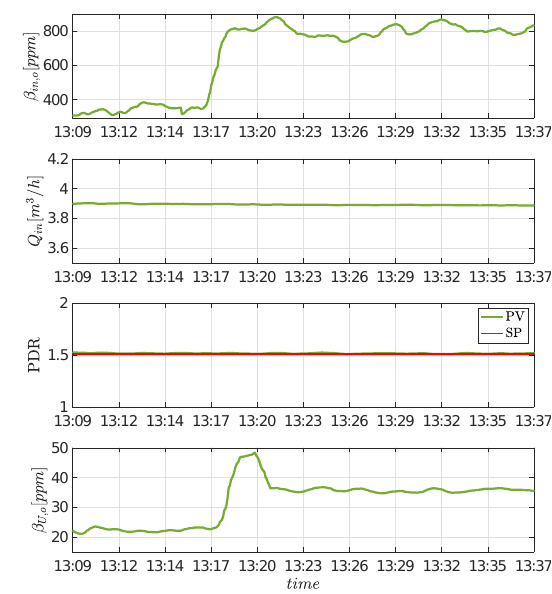
Figure 5: Laboratory experiment showing increase in the β U,o with increase in β in when fixed PDR